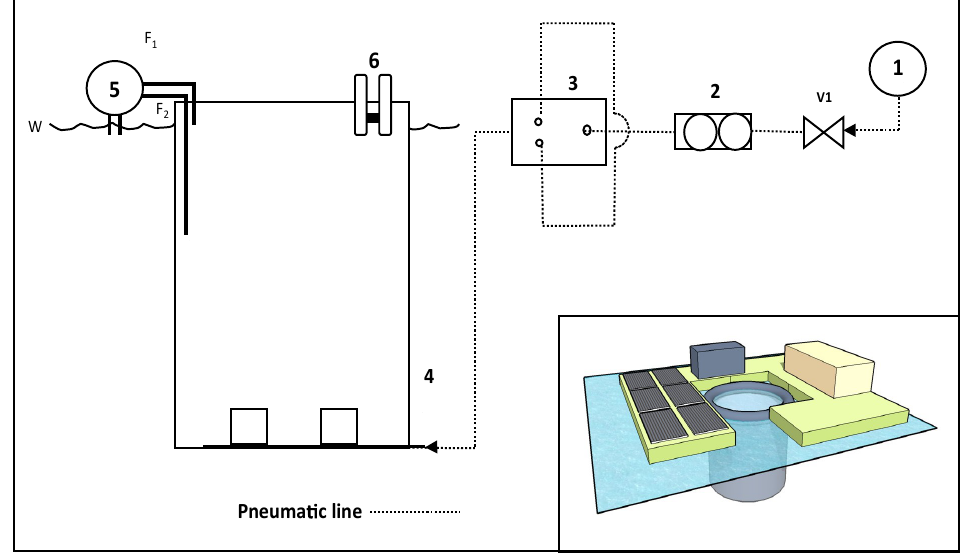
Figure 5. eFLOAT process based on a modular pontoon design (Inset: 3D eFLOAT design). Full capital expenditure (CAPEX) and operating expenditure (OPEX) figures are given in Table